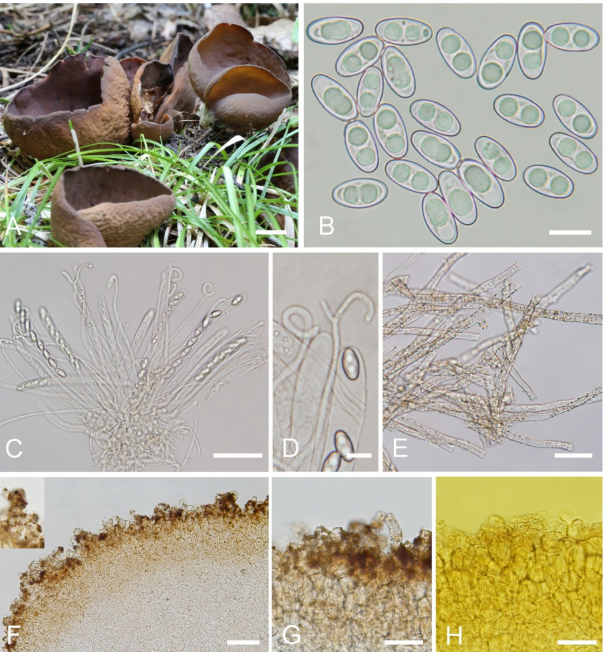
Figure 4. Otidea cupulata (HSA 218) ( A ) apothecia, ( B ) ascospores, ( C ) asci and paraphyses, ( D ) paraphyses, ( E ) basal mycelium, and ( F ) ectal and medullary excipulum in water, ( G ) ectal excipulum in water, ( H ) ectal excipulum in MLZ. Scale bars: ( A ) = 1 cm, ( B ) = 10 µ m, ( C ) = 50 µ m, ( D ) = 10 µ m, ( E ) = 25 µ m, ( F ) = 50 µ m, ( G , H ) = 30 µ